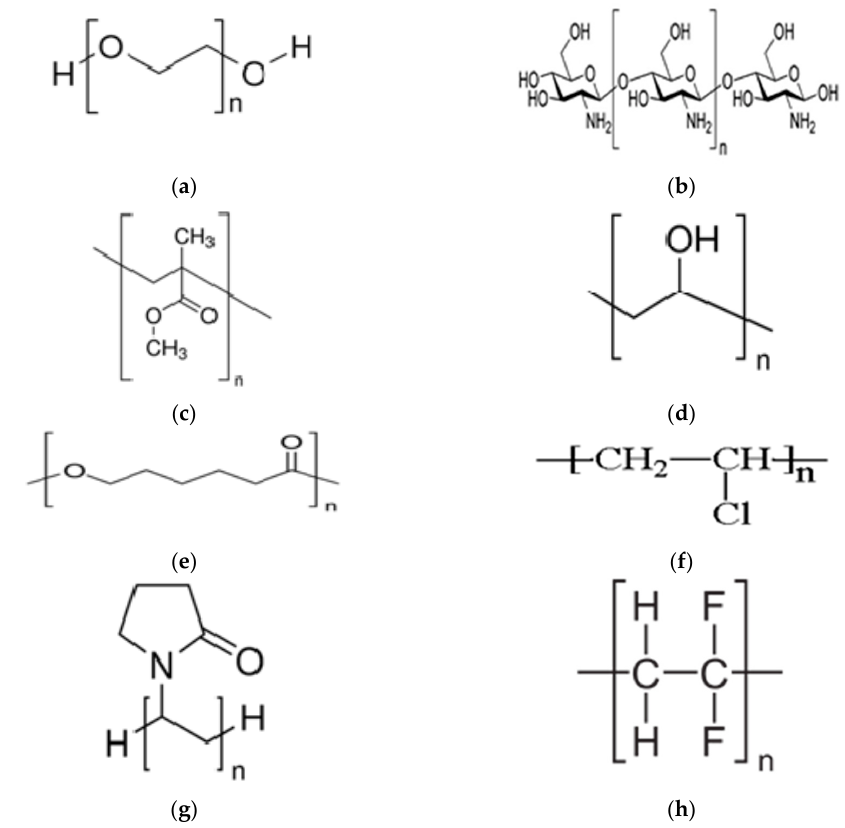
Figure 1. Various commonly used polar polymers structure in polymers electrolyte: ( a ) polyethylene oxide (PEO); ( b ) chitosan (CS); ( c ) poly methyl methacrylate (PMMA); ( d ) poly vinyl alcohol (PVA); ( e ) poly ξ -caprolactone (PCL); ( f ) poly vinyl chloride (PVC); ( g ) poly vinylpyrrolidone (PVP); ( h ) poly vinylidene fluoride (PVDF) [26,27].